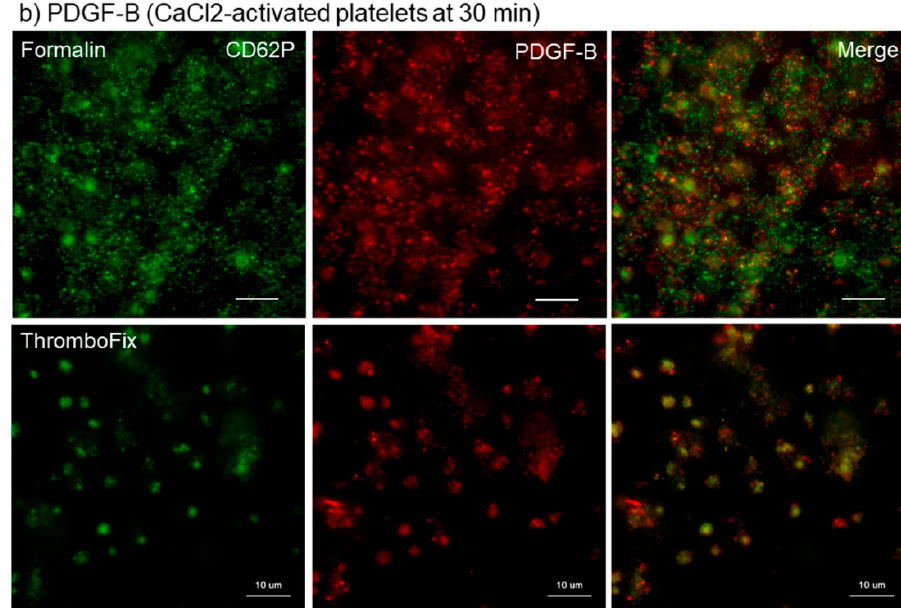
Figure 2. Different effects of fixatives on visualization of PPAR γ and PDGF-B in Ca 2+ -activated platelets aggregated and adhered onto cp -Ti plates. Platelets were treated with 0.1% CaCl 2 in PBS, incubated on cp -Ti plates for 30 min and fixed with 10% neutral buffered formalin or ThromboFix without intensive washing. ( a , b ) Activated platelets (CD62P; green), ( a ) PPAR γ (red), and ( b ) PDGF-B (red) were visualized by immunofluorescence. Similar findings were obtained from the samples prepared from the other three donors. Bar = 10 μ m.